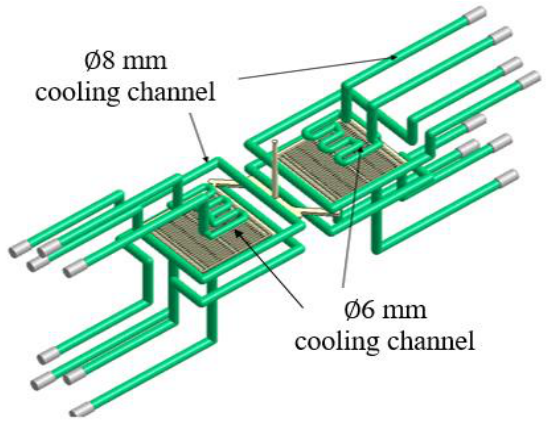
Table 2. Specification of the pressure sensors. Item